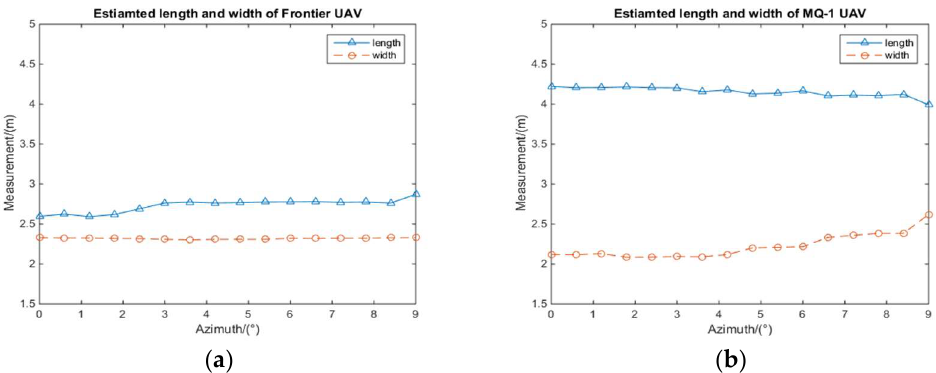
Figure 9. The estimated length and width of the “Frontier” and “MQ-1” UAVs. ( a ) Estimated length and width of the “Frontier” UAV; ( b ) Estimated length and width of the “MQ-1” UAV.